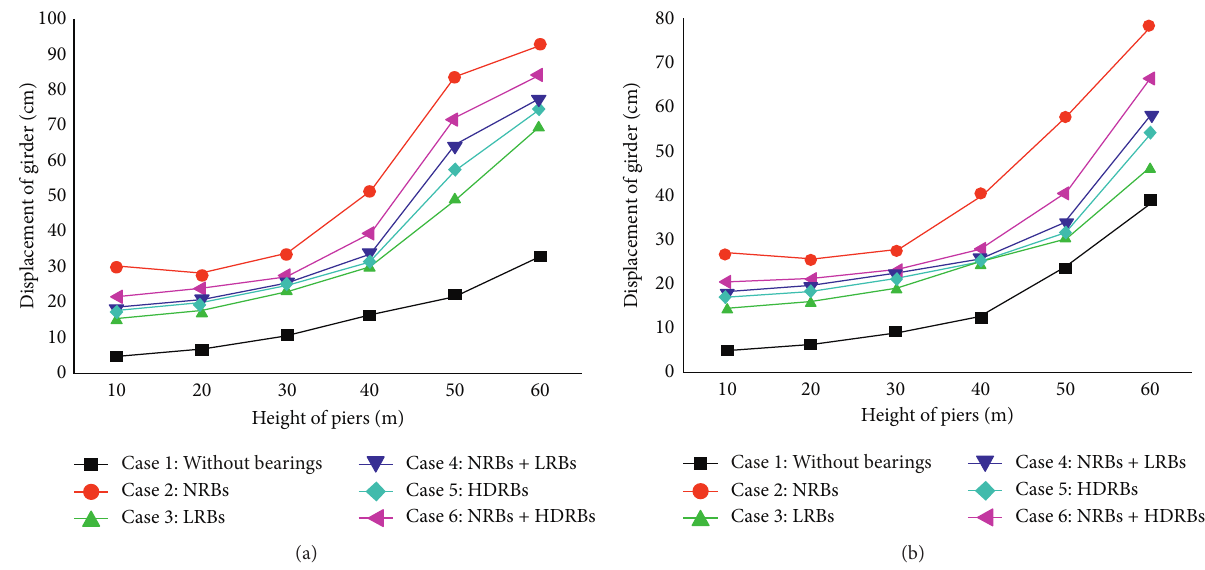
Figure 15: Displacement of girder with the change of pier height in different cases: (a) longitudinal; (b) lateral.